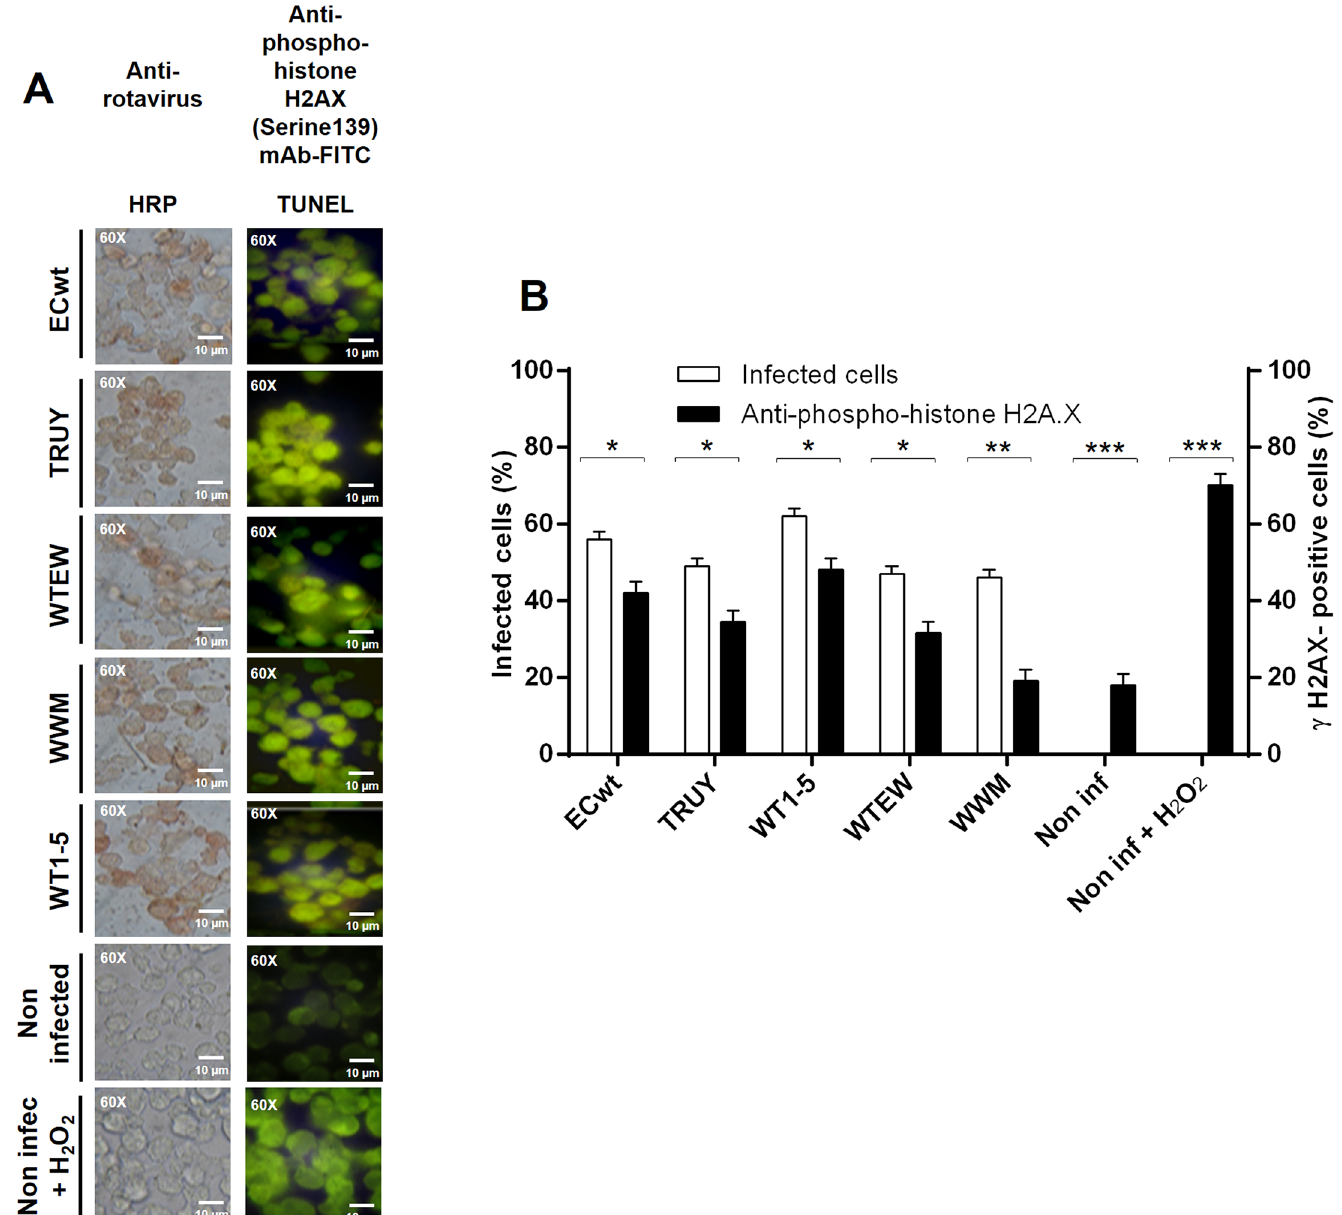
Fig 7. Induction of γ H2AX accumulation by rotavirus infection. Sp2/O-Ag14 cells were infected with tumor cell-adapted rotavirus isolates WTEW, TRUY, WT1-5, WWM or ECwt at MOI of 0.8 and harvested at 12 h.p.i. (A) Immunocytochemistry analysis of infected cells using primary Abs against rotavirus SP and HRP-conjugated goat anti-rabbit secondary antibodies. For phospho-histone H2A.X analysis, cells were permeabilized with 0.5% Triton X-100 and blocked with 3% BSA in TBS buffer. Cells were treated first with anti-phospho-histone H2A.X (Ser 139) mAb (2 μ g/ml) and then with FITC-conjugated goat anti-mouse secondary Ab (2 μ g/ml). Uninfected cells treated or not with H 2 O 2 (1 mM) were used as a control. (B) Comparison of the mean percentages of cells being positive to rotaviral antigen and γ H2AX foci.